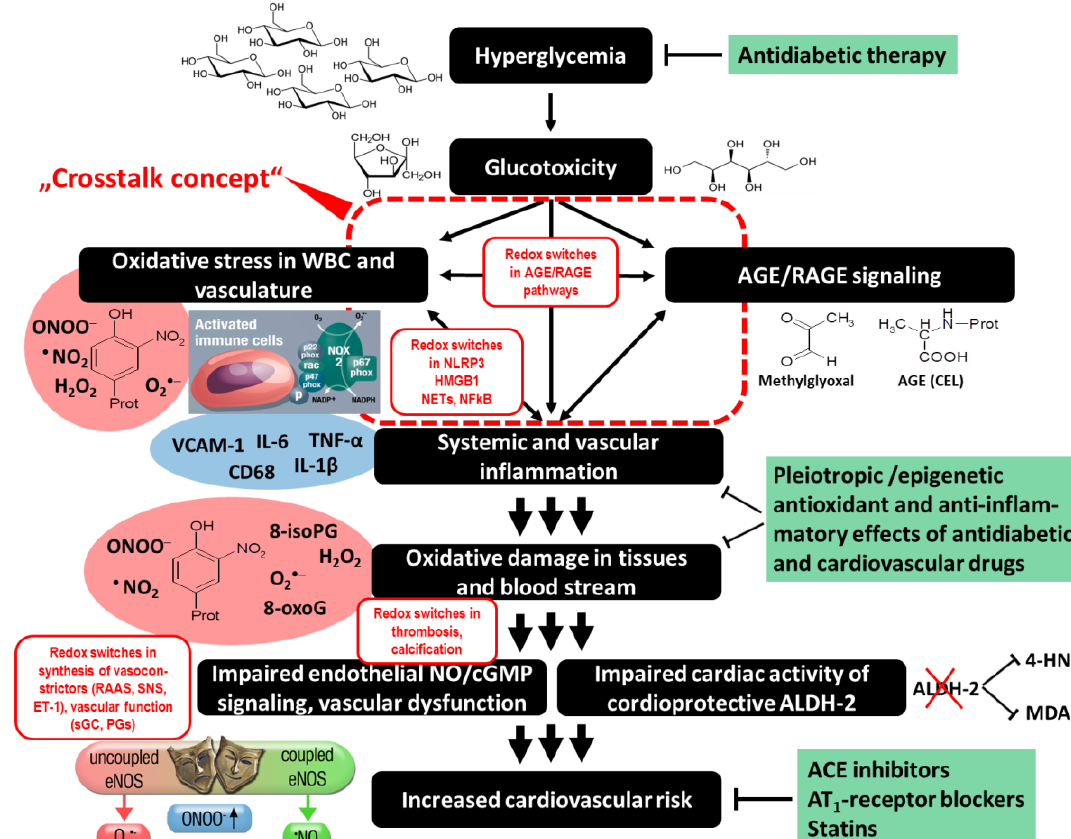
Figure 6. Extension of the cross talk concept from ROS sources to pathways initiated by hyperglycemia and glucotoxicity (fructose and sorbitol overproduction) such as inflammation (typical diabetic markers in the blue elliptic box), AGE/RAGE signaling (typical AGE members: precursor methylglyoxal and protein adduct N ε -(carboxylethyl)-l-lysine), synthesis of vasoconstrictors, regulation of thrombosis, calcification, and vascular function. Typical diabetic ROS and oxidative damage markers are shown in the red elliptic boxes. The major therapeutic targets of current antidiabetic and cardiovascular therapies are reflected by green text boxes. NETs, neutrophil extracellular traps; NLRP3, NLR Family Pyrin Domain Containing 3 inflammasome; HMGB1, high-mobility group box 1; VCAM-1, vascular cell adhesion molecule-1; IL, interleukin; TNF-α, tumor necrosis factor alpha; CD68, cluster of differentiation 68 (macrosialin); 8-isoPG, 8-isoprostane; 8-oxoG, 8-oxoguanine; RAAS, renin–angiotensin–aldosterone system; SNS, sympathetic nervous system; ET-1, endothelin-1; mtROS, mitochondrial ROS; DAMPs, damage-associated molecular